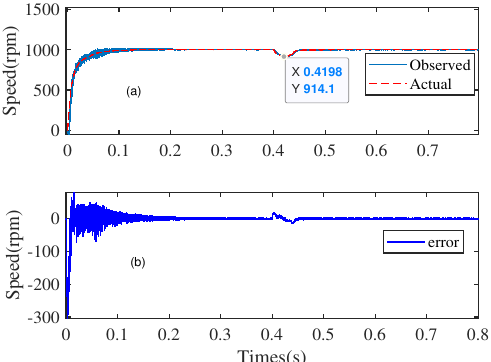
Figure A1. The speed response of VPDPI regulator when R s = 0.0011 and J = 0.0008. ( a ) Observed speed and actual speed. ( b ) Estimation error